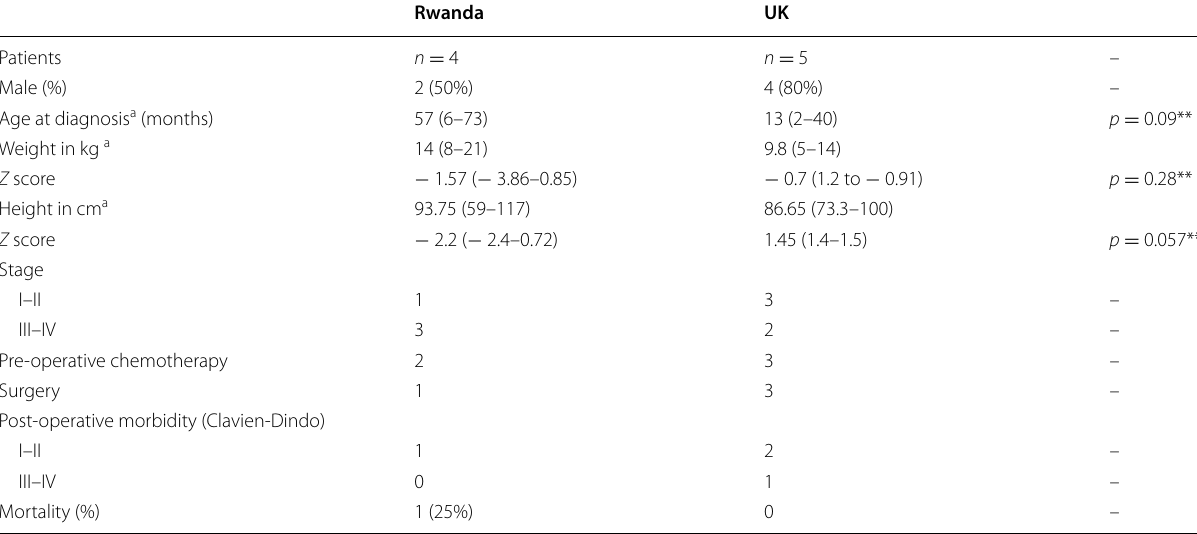
Table 2 Patients diagnosed with neuroblastoma presenting at two collaborating centres over the 29-month study